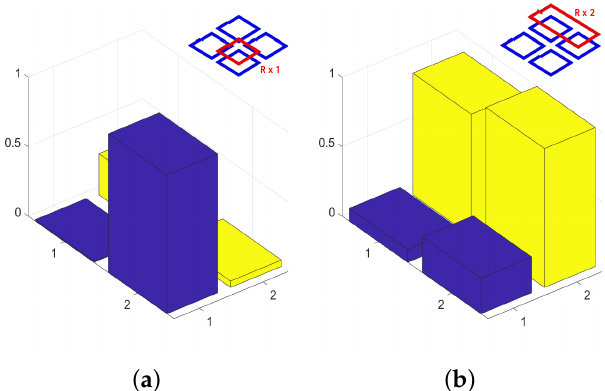
Figure 8. Eigenvector distribution. ( a ) H H R R H ( Rx 1 ) . ( b ) H H R R H ( Rx 2 ) .